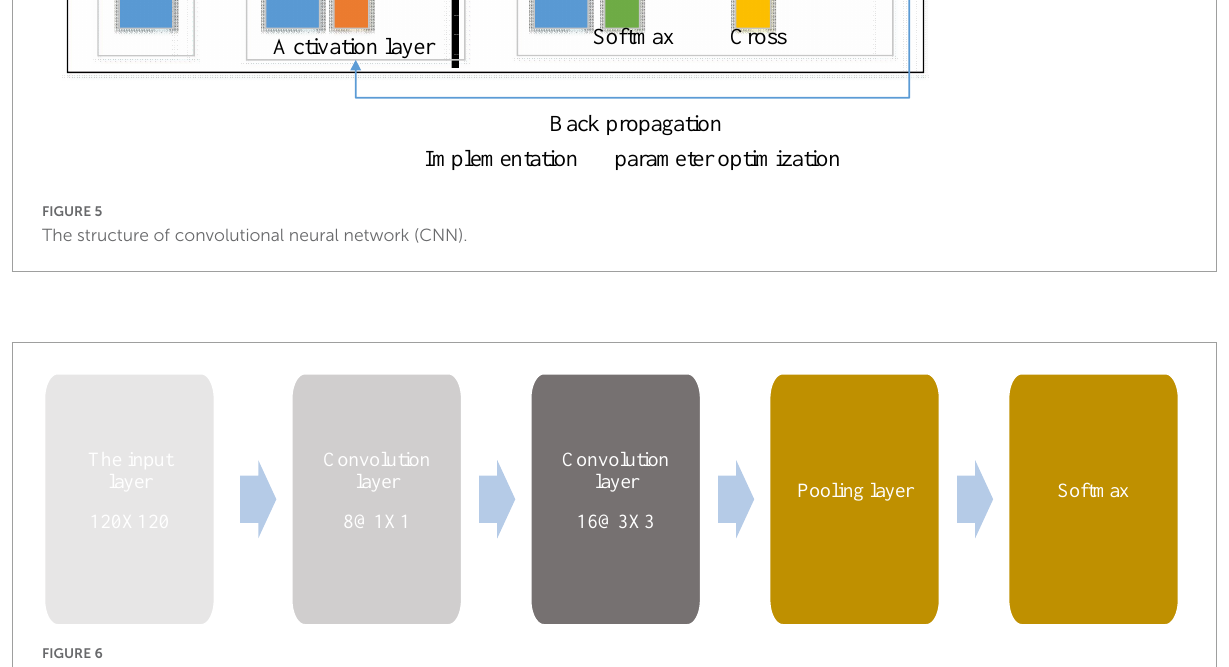
FIGURE6 Improved LeNet-5 network